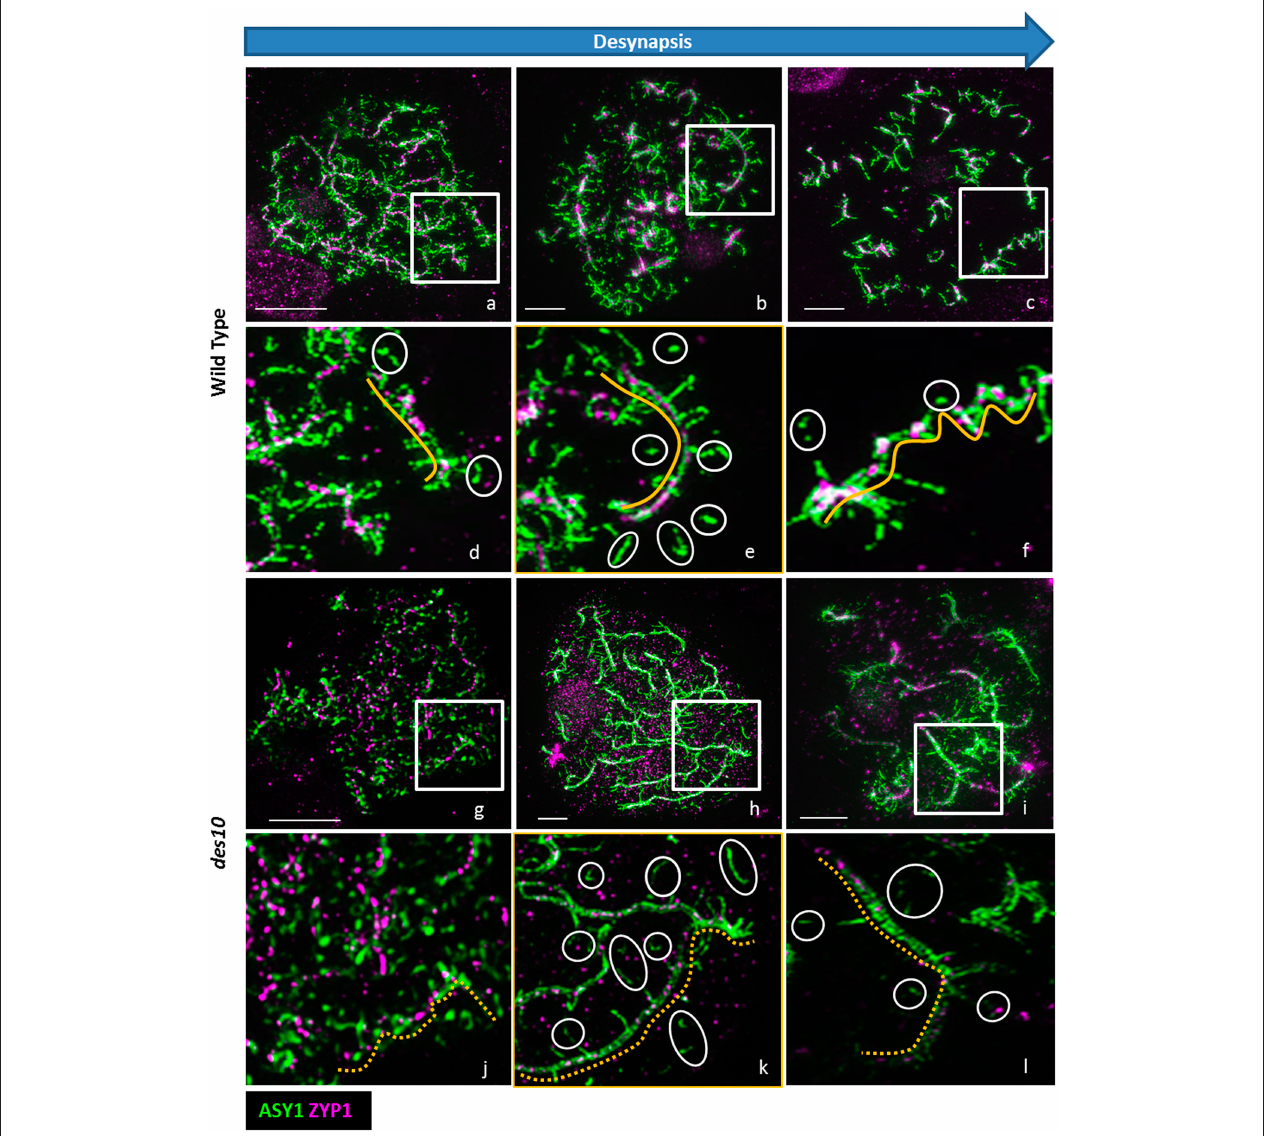
FIGURE 3 | ASY1 re-organization during desynapsis. De-synapsis was monitored with 3D-SIM using ASY1 (green) and ZYP1 (magenta) in barley wild type (a–f) and des10 (g–l) . Enlarged areas of wild type (d–f) and des10 (j–l) slides show the organization of ASY1 along the ZYP1 axes (yellow lines). White circles highlight isolated ASY1 signals (d–f) that may represent the process of dissolution of ASY1 after the tinsel structure organization. In des10 (j–l) , ZYP1 axes are not linear (dashed yellow lines), but ASY1 displays a similar behavior to wild type.